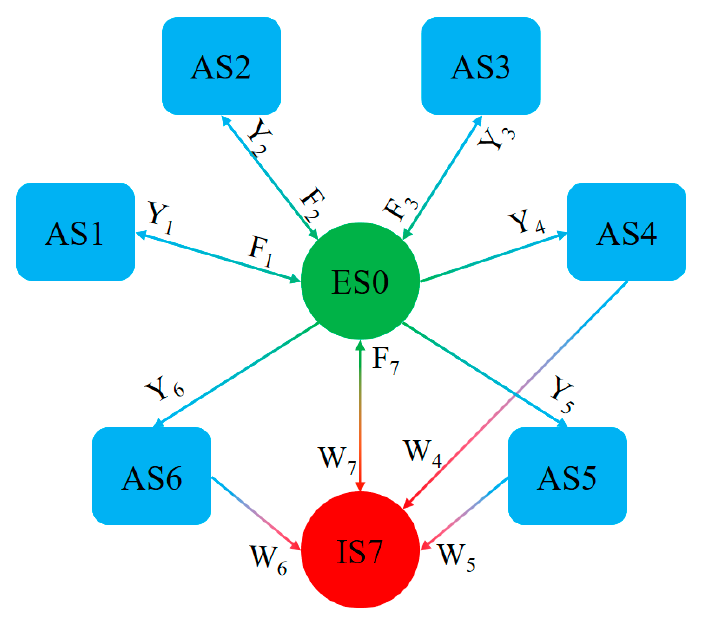
Figure 3. State transition diagram of the device.